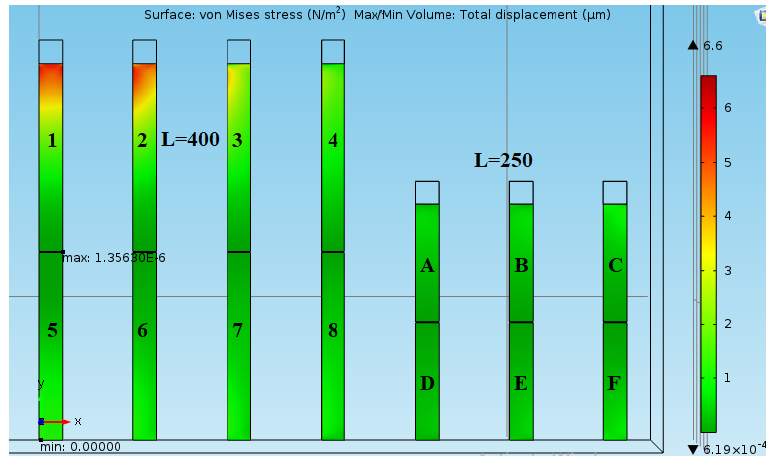
Figure 11. Von Mises stress distribution in MLCs with L = 400 and 250 µ m when the real chip is simulated. Airflow with a velocity of 5 m / s from a hole with a diameter of 10 µ m and about 400 µ m above the substrate is directed on the chip. This is the real chip under the action of airflow that exactly demonstrates the influences of air on the MCLs that could be used for designing the AbFM system. The microhole is developed through the center of the simulation box which is near the MCL1. Accordingly, there is more sensitivity toward airflow velocity in MCL1, MCL2, and MLC3, which are closer to microhole.